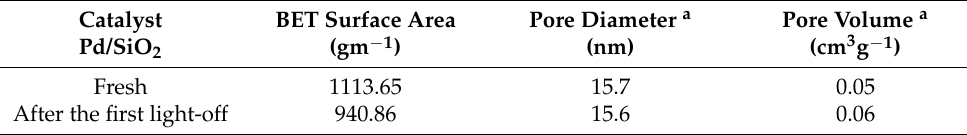
Table 2. Structural properties of fresh Pd/SiO 2 aerogel catalysts and after the first light-off.